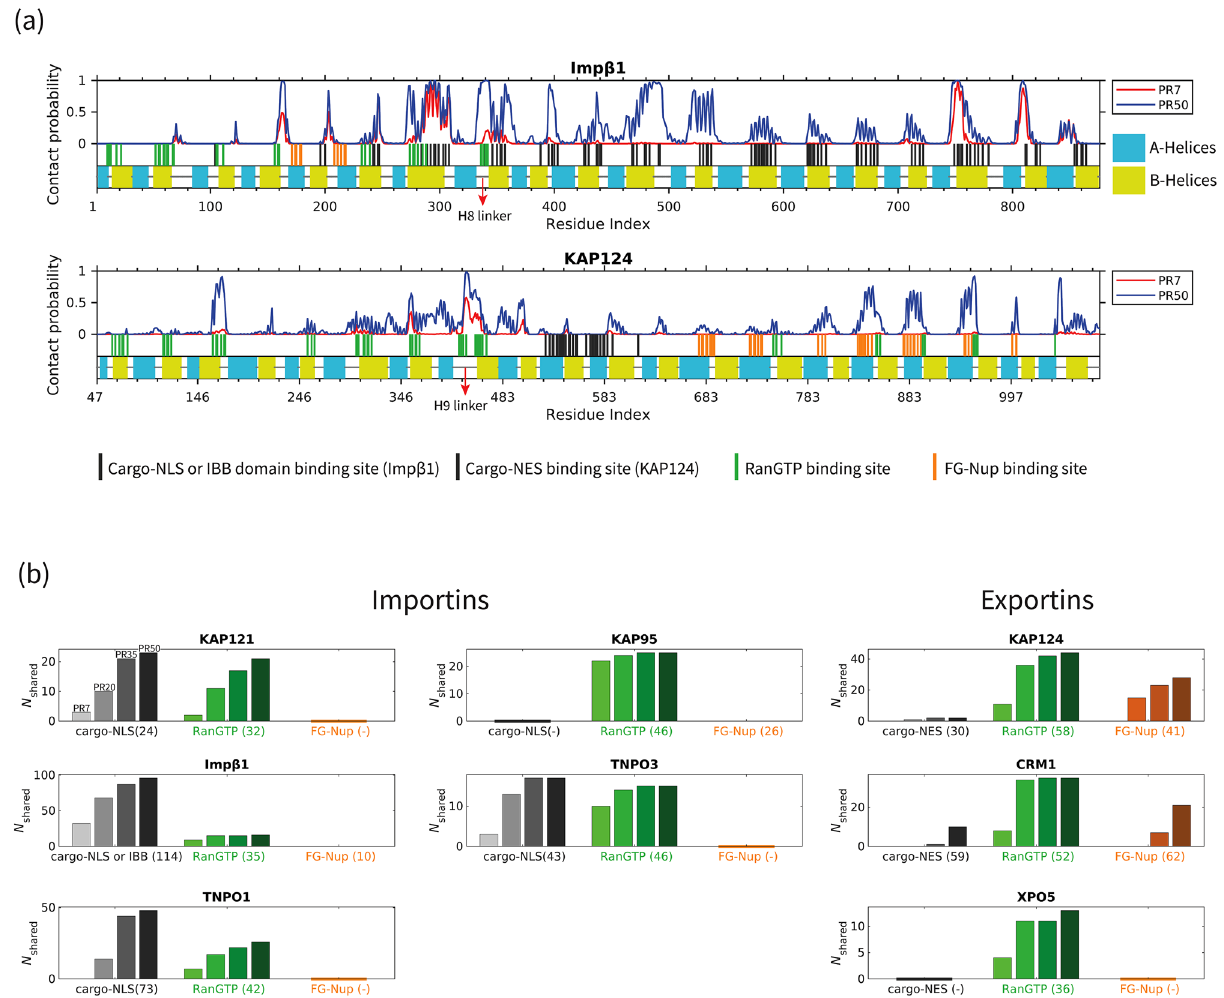
Figure 3. Poly-PR interacts with Kapβs sites used for the recognition of NLS-cargo, IBB, RanGTP and FG-Nups in a poly-PR-length-dependent manner. ( a ) The contact probability of each Kapβ residue in interacting with poly-PR plotted against the residue index for the Impβ1 importin and the KAP124 exportin at monovalent salt concentration C salt = 100 mM. See Fig. S7 for the results for other Kapβs. In each figure, the curves correspond to PR7 and PR50. In the bottom part of each figure, the first row shows the known binding sites for NLS/NES-cargo, IBB domain, RanGTP, and FG-Nups. These binding sites are obtained from the crystal structures of the bound states of Kapβs in the Protein Data Bank using PiSITE, see Table S3 of the SI for more details. For importins, residues that bind to NLS-cargo and IBB domain, and for exportins residues that bind to NES-cargo, are shown with vertical black lines. The residues that bind to RanGTP and FG-Nups are shown with vertical green and orange lines, respectively. The RanGTP data contains binding residues for both RanGTP and RanGppNHp which is the non-hydrolysable form of RanGTP. The second row in each figure shows the A- and B-helices in light blue and yellow, respectively. The linkers that connect the helices are shown with grey horizontal lines. The H8 loop of Impβ1 and the H9 loop of KAP124 are highlighted with red arrows. ( b ) Number of contact sites shared between poly-PR and the binding partners of Kapβs, N shared , plotted for PR7, PR20, PR35, and PR50. In each bar plot, the numbers inside the parentheses on the horizontal axis shows the number of the known binding sites obtained from PiSITE. We use a (-) mark if there is no known binding site. As can be seen, for importins, a limited number of FG-Nup binding sites are available. In each set of bar plots, we report the results for PR7, PR20, PR35, and PR50 (from left to right). Bars with darker colors correspond to longer poly-PR